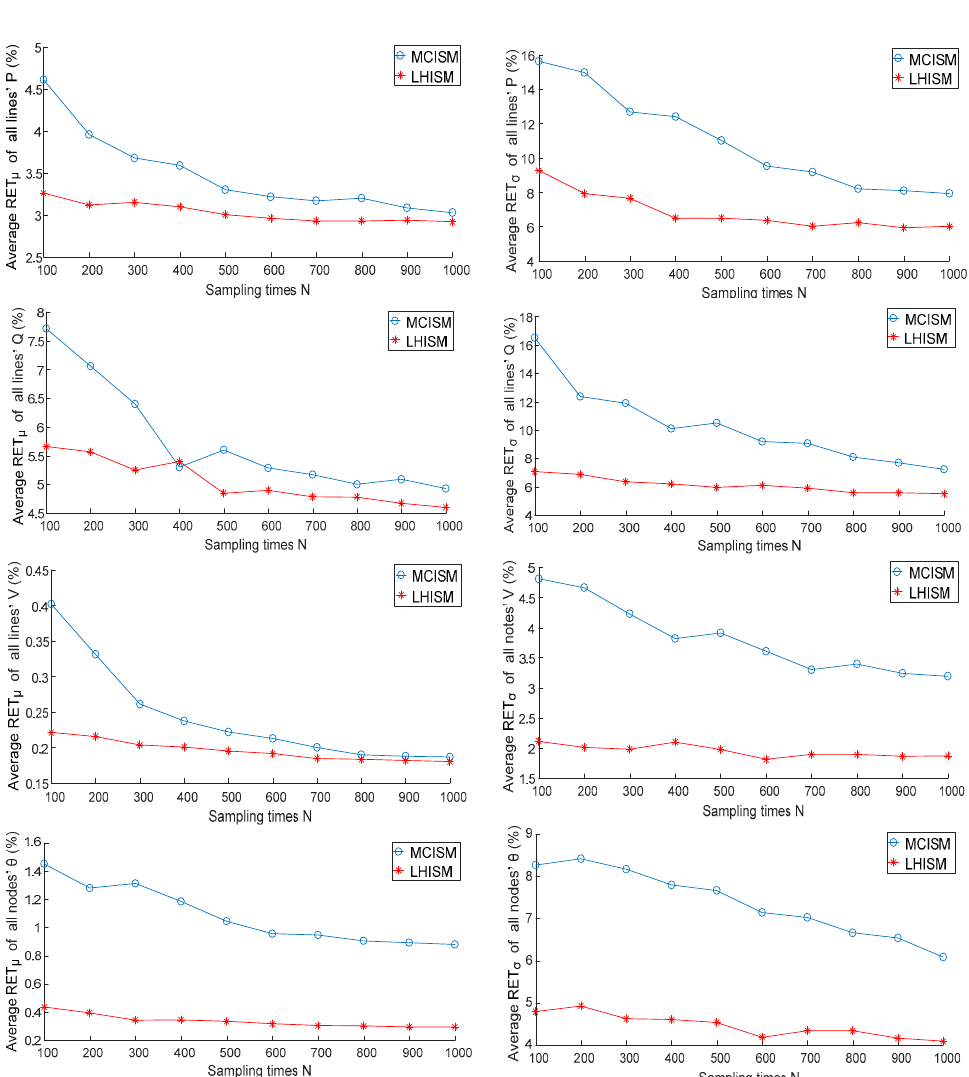
Figure 6. Error comparison of power flow results between two methods.